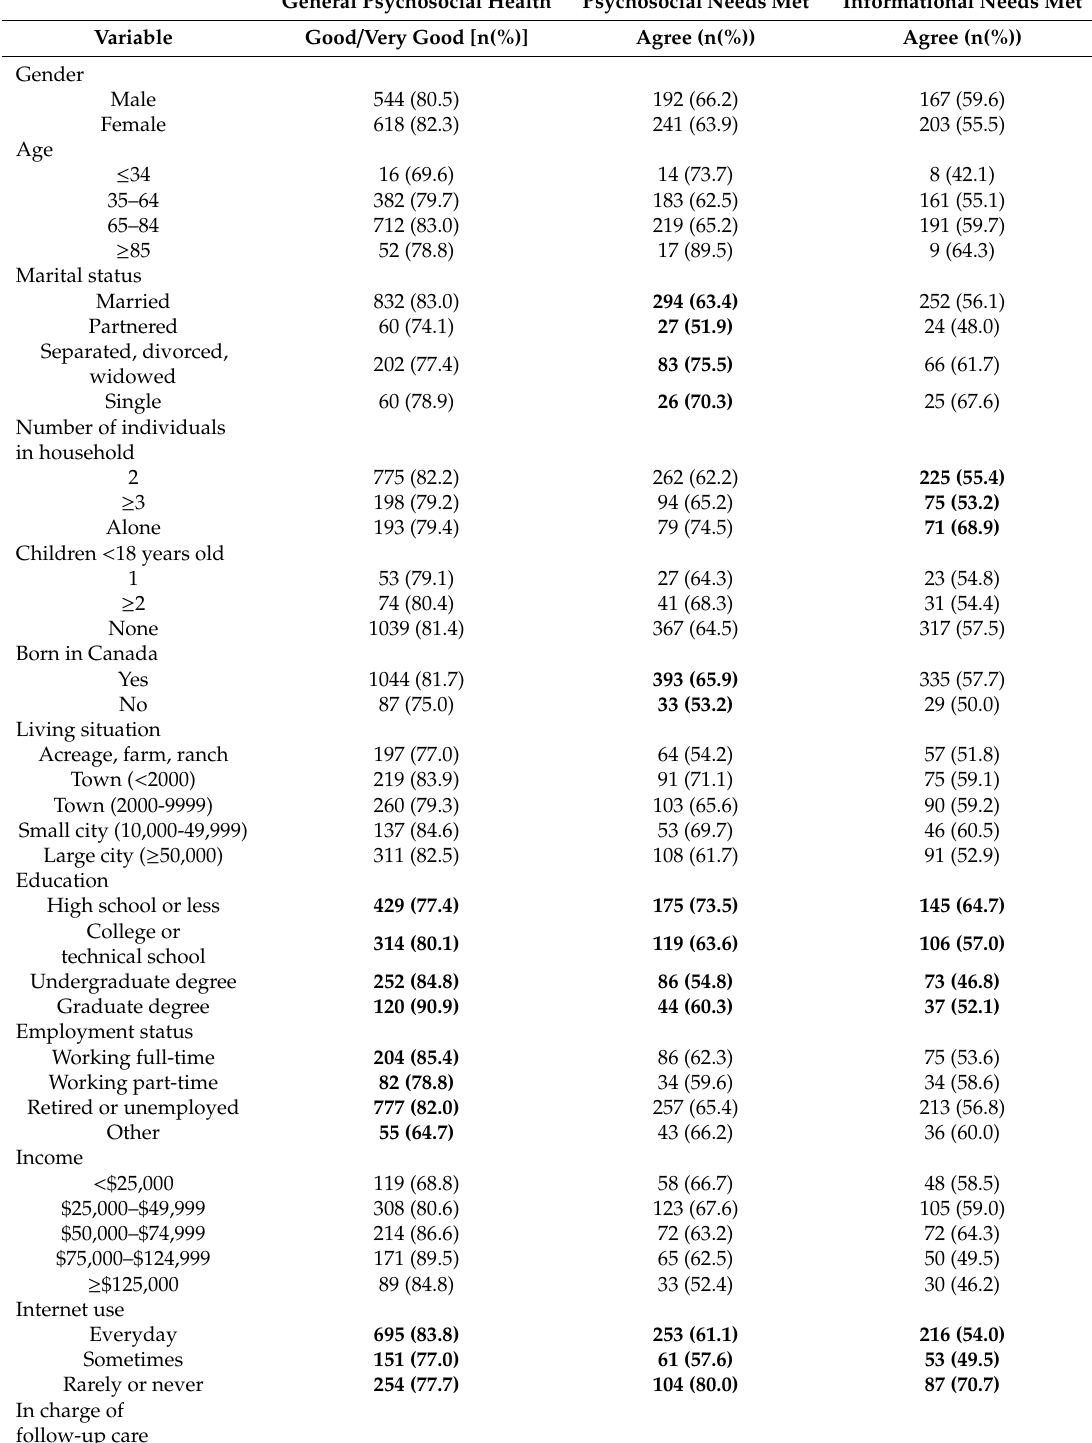
Table 4. Relationship between sociodemographic / clinical factors and general psychosocial health and psychosocial / informational needs